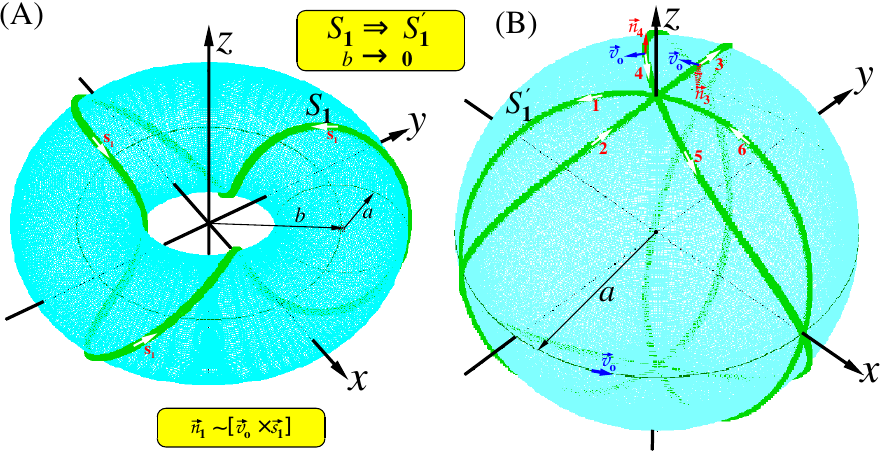
Figure 11. ( A ). Green string S 1 having parameters ω 0 = 1, φ 0 = 0, and ω 1 = 1/3, φ 1 = π is drawn on surface of the torus having radiuses a = 1, b = 2. The current flowing along the string is drawn by white arrows and marked by red letters s 1 ; ( B ). Green string S (cid:48) drawn on the surface of the doubled sphere with radiuses a = 1, b = 0. The current flowing along this 1 string is drawn by white arrows and marked by red numbers 1, 2, 3, 4, 5, 6. Blue arrows point rotation of the sphere about axis z with the orbital velocity (cid:126) v o . The cross product of the velocity (cid:126) v o by the current gives the normal to the sphere surface that is oriented either outside the surface (red arrow (cid:126) n 4 ) or inside it (punctuated red arrow (cid:126) n 3 ).